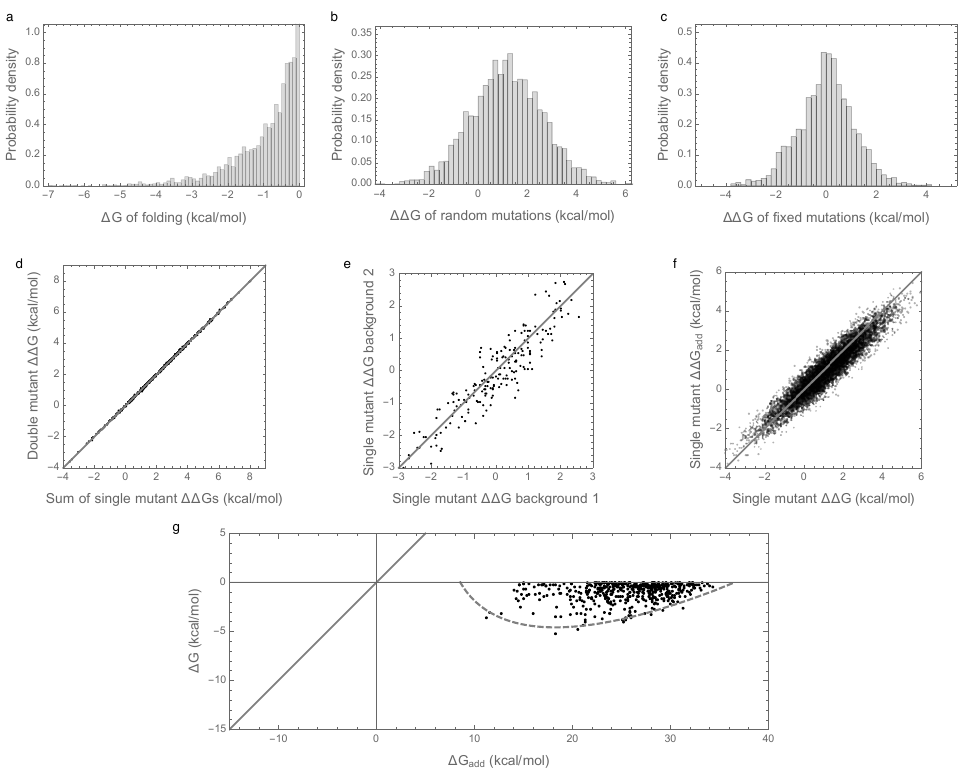
Figure 1. Free energy of folding, stability effects of mutations, and contribution of additive effects to folding stability under the pairwise epistatic effects model: ( a ) Distribution of free energy of folding for evolved sequences; ( b ) distribution of stability effects of random mutations, i.e., distribution of ∆∆ G values for a random single mutant generated from a random evolved sequence, where ∆∆ G is the change in the ∆ G of folding due to the mutation; ( c ) distribution of stability effects of fixed mutations, i.e., distribution of ∆∆ G values corresponding to two distinct neighboring sequences along the simulated trajectory; ( d ) stability effects of double mutations versus the sum of the stability effects of the two single mutations. 500 random double mutants are shown, R 2 = 0.9997; ( e ) effects of single mutations that fixed along the trajectory in two evolved backgrounds that differ by 50% sequence divergence, R 2 = 0.87; ( f ) the stability effect of a random mutation on ∆ G is highly correlated with the stability effect of the mutation on the additive contribution ∆ G add , R 2 = 0.89; ( g ) free energy of folding versus additive contribution to free energy of folding for evolved sequences. The additive contribution to folding is not a good indicator of the total free energy of folding ( R 2 = 0.06) and observed sequences cannot fold spontaneously based on the additive contribution alone. The dashed gray curve is derived from our bivariate normal approximation and is predicted to contain 95% of the evolved sequences. Simulations conducted under the pairwise epistasis model with µ add = 1 kcal/mol, = 1 kcal 2 /mol 2 , and σ 2 = 0.0003 kcal 2 /mol 2 σ 2 epi add